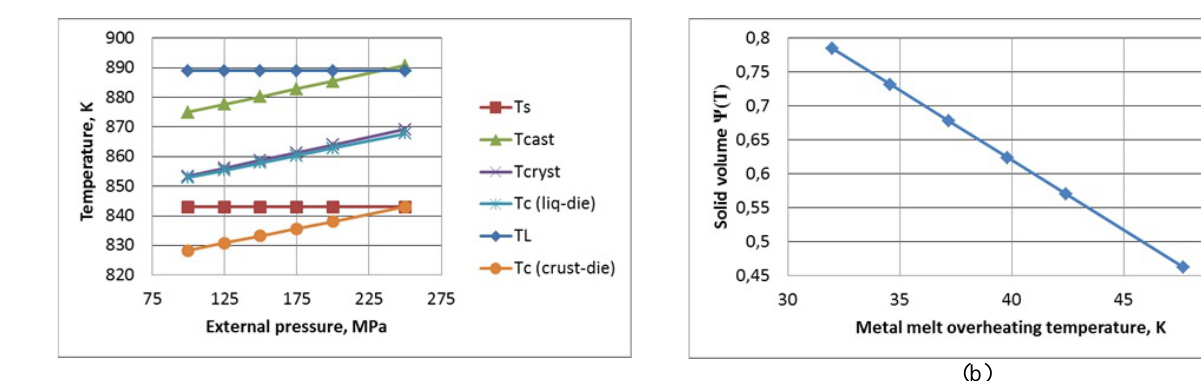
Fig. 3. Dependence of the superheat temperature removal time (a) on the contact surface temperature and the effect of the melt superheat temperature on the solid phase fraction during solidification in the temperature range (b).